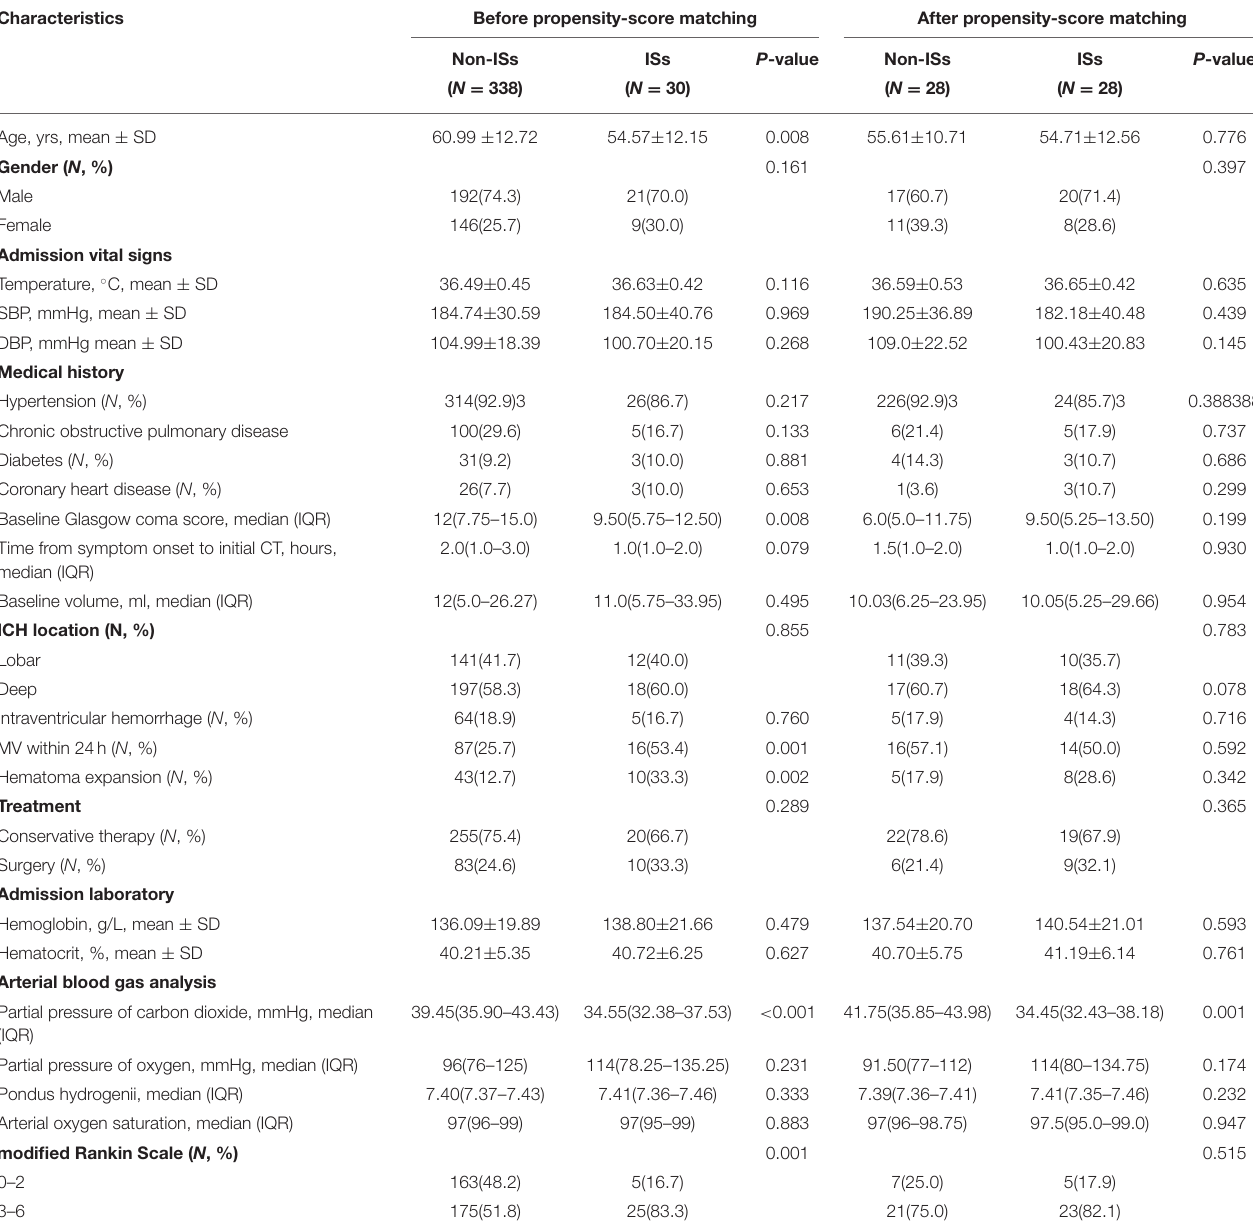
TABLE 1 | Univariate analysis of association with ISs before and after propensity-score matching in spontaneous intracerebral hemorrhage patients. Characteristics Before propensity-score